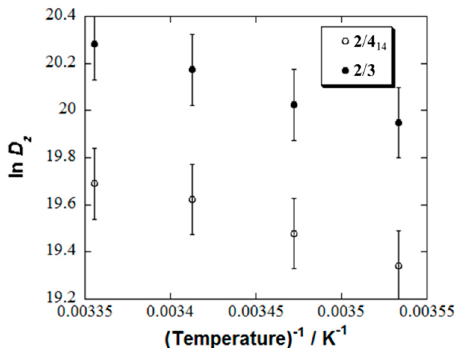
Figure 4. Temperature dependence of rotation diffusion coefficient D z of 4 14 in 2 / 4 14 and 3 in 2 / 3 . The data of 2 / 3 was cited from reference 19. See the Supplementary Information for experimental details of 2 / 4 14 . Table 2. The effective activation energy of the rotation diffusion of 4 14 in 2 / 4 14 and 3 in 2 / 3 . Mixed micelle